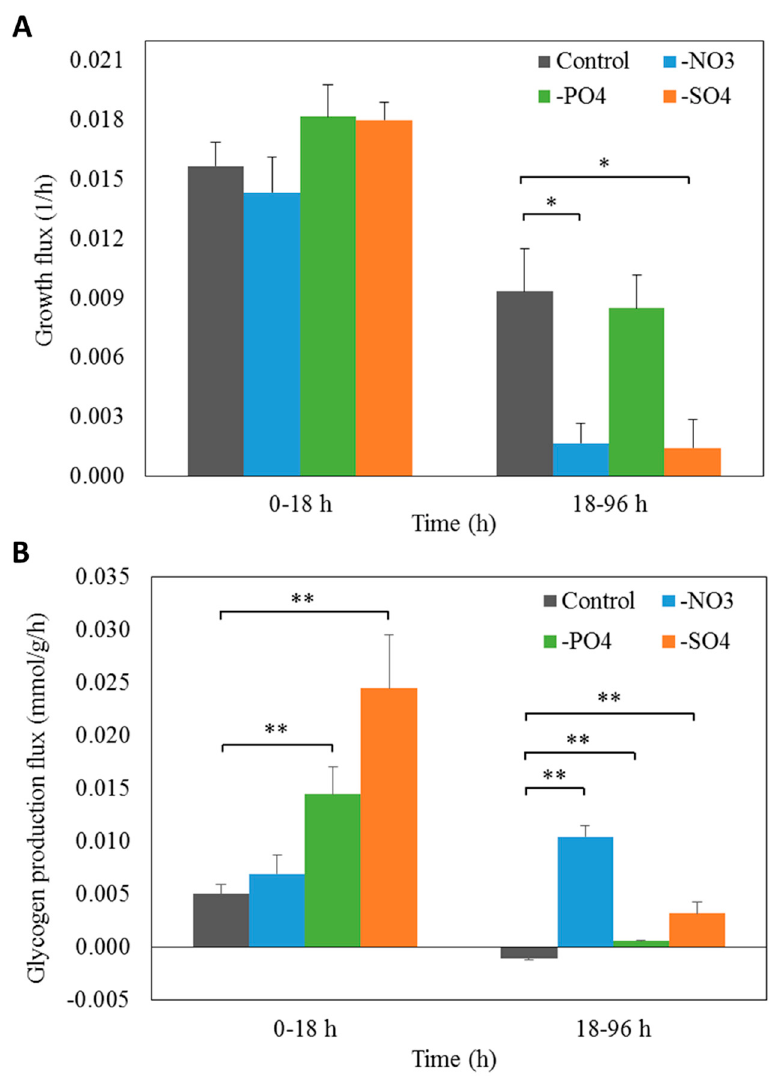
Figure 6. The specific growth rate growth ( A ) and the glycogen production flux ( B ) under the control, NO 3 − -depleted, PO 43 − -depleted and SO 42 − -depleted conditions. * and ** represent significant difference at the p -value < 0.05 and the p -value < 0.01, respectively.